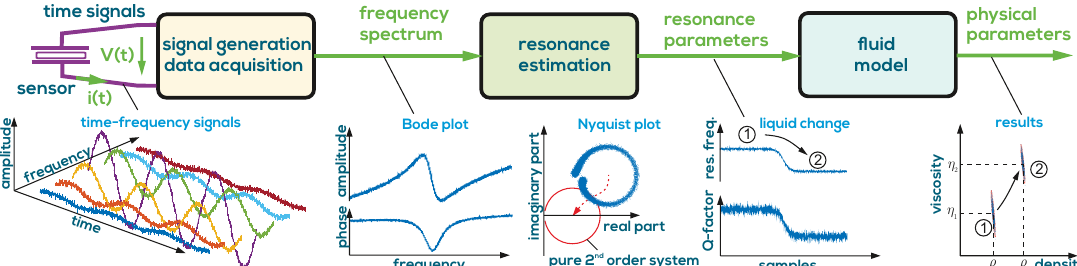
Figure 2. The processing of the data follows the measurement chain. A data acquisition system gives the frequency spectra which are processed by a resonance estimation algorithm. The resonance parameters are related to density and viscosity values ρ and η by a sensor model with predictable error propagation from measurement noise on the time